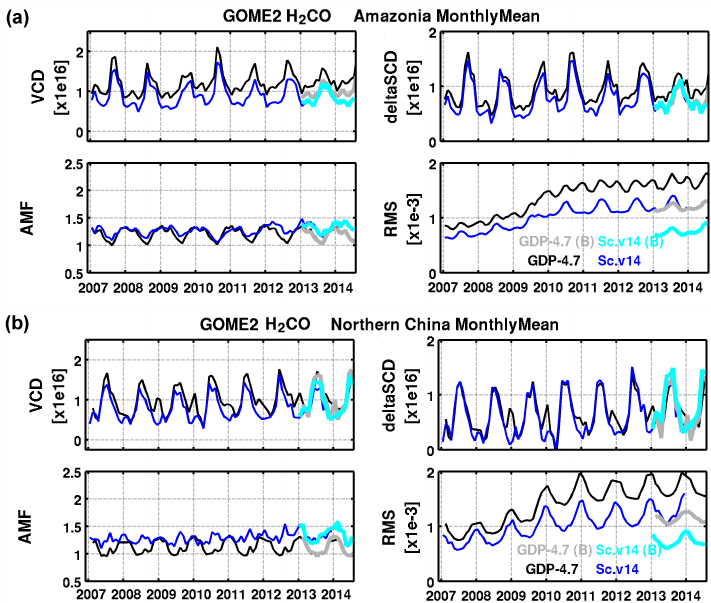
Figure 11. Example of HCHO end-to-end validation for (a) the Guatemala and (b) northern China regions. Monthly means comparisons of GOME-2A and GOME-2B GDP data (black and grey) are compared to the corresponding scientific algorithm v14 (blue and cyan) for every step of the VCD retrieval: the normalised slant columns (delta SCD), the DOAS fit RMS (indicator of the fit quality), the cloud-corrected (total tropospheric) air mass factor AMF and the tropospheric vertical column